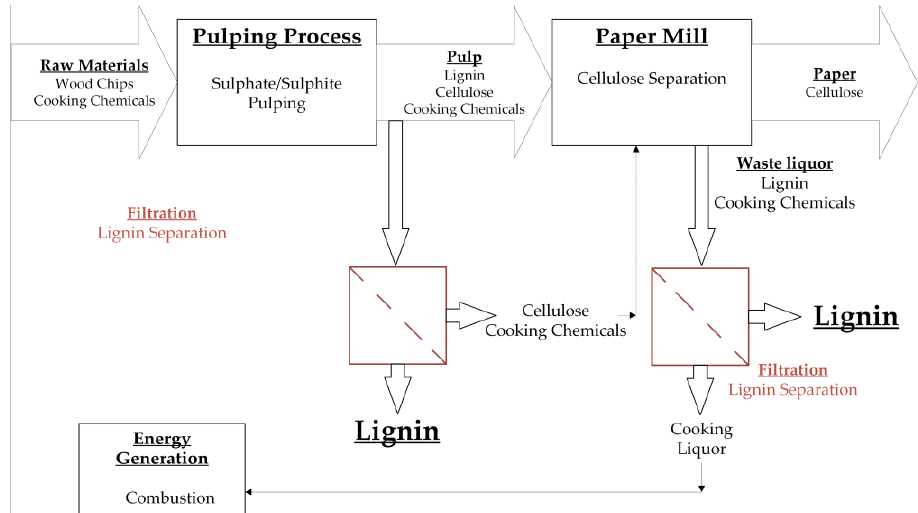
Figure 1. Summary of different strategies in which membrane fractionation can be used for the treatment of waste liquor from the pulp and paper industry. During the pulping process, the raw material is separated into cellulose and lignin. The pulp can be treated by membrane filtration to isolate lignin molecules. The remaining solution can be recycled to the paper production. Additionally, the waste liquor from the paper mill can be treated by membrane filtration to isolate the containing lignin. The remaining solution can be recycled for energy generation.